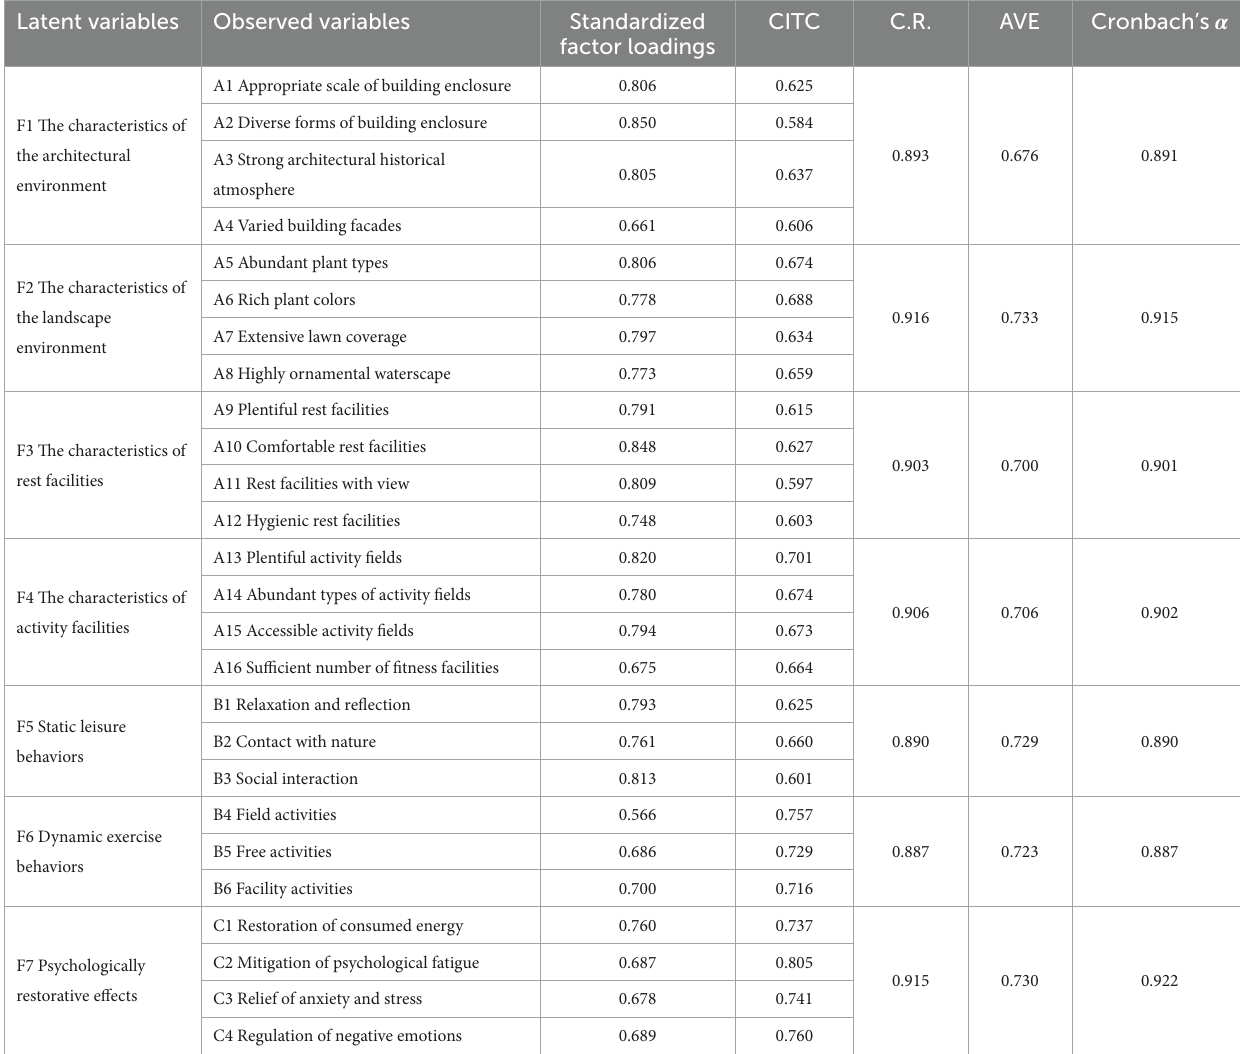
TABLE 2 Analysis results of model reliability, validity, and